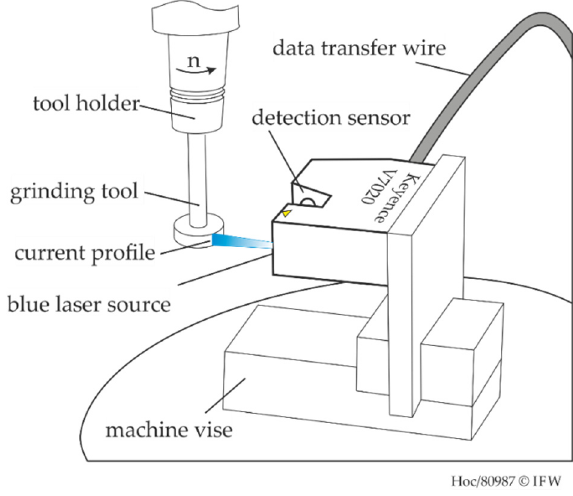
Figure 2. Setup of in-machine measuring system.